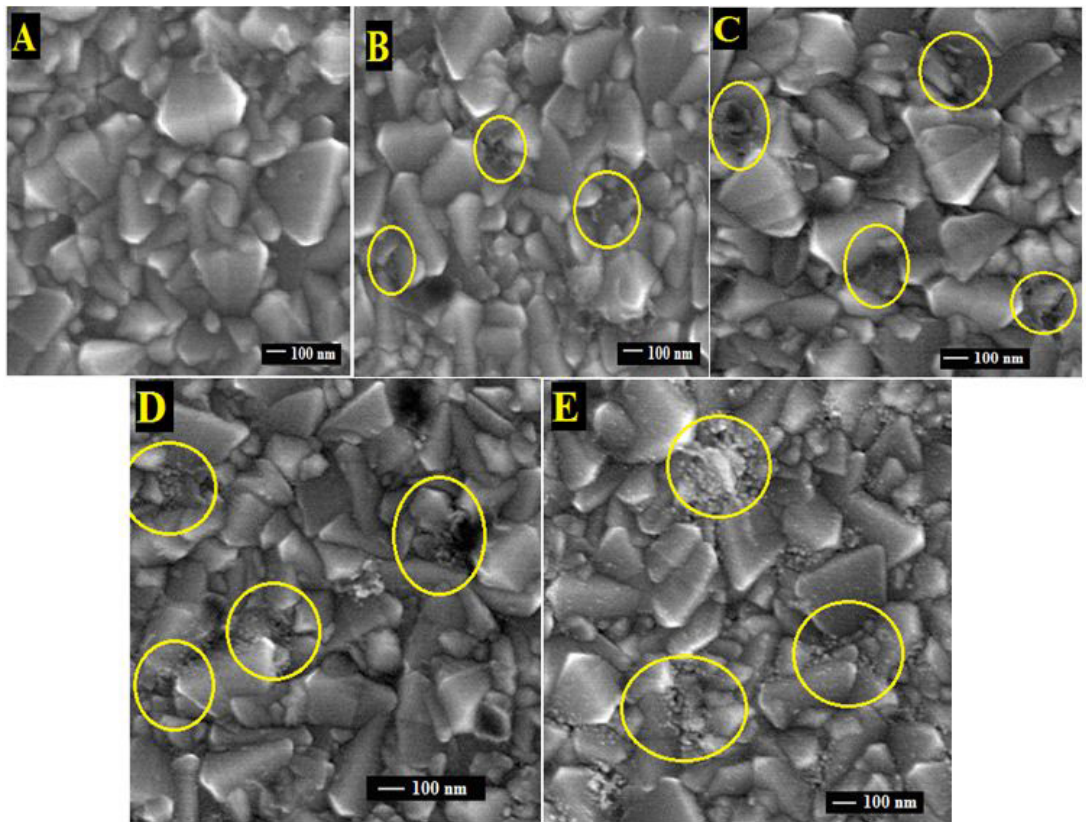
Figure 9. FESEM photographs of Pt/ FTO thin films A. bare FTO B. Pt2.5, C. Pt5, D. Pt10 and E. Pt15.